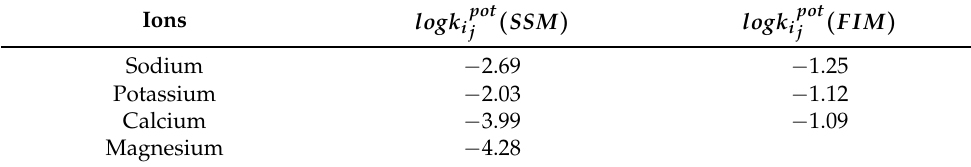
Table 1. The selectivity coefficients of the HERS over potentially interfering ions ( j ). Ions logk ipot